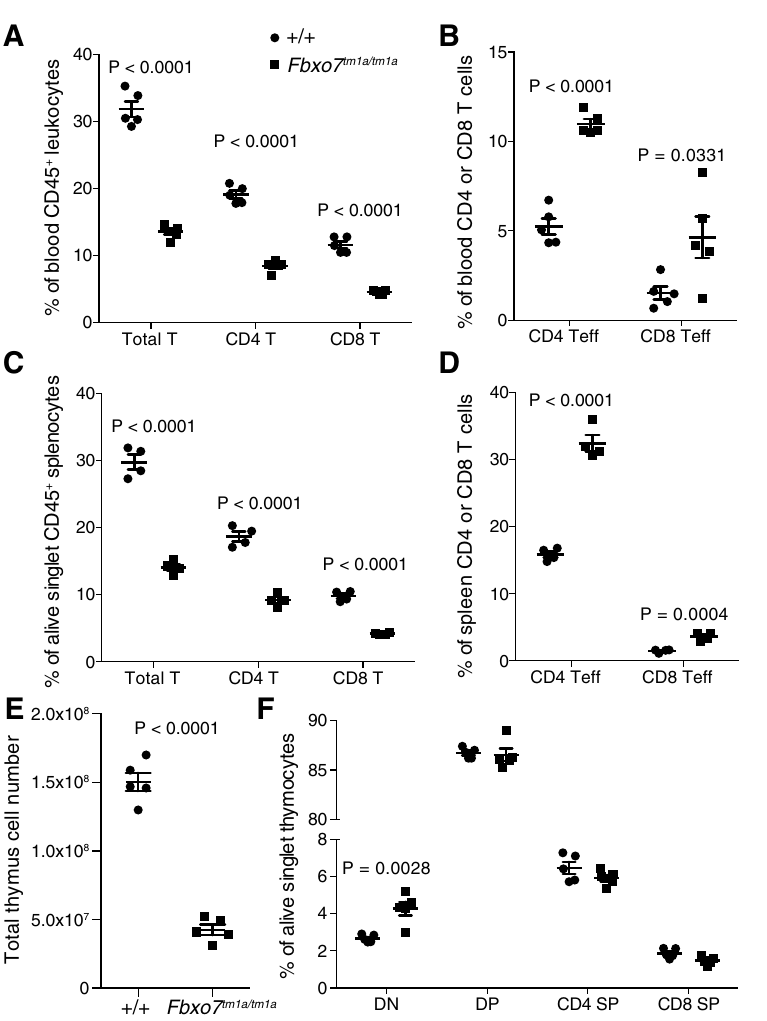
Fig 3. Fbxo7 tm1a mice have reduced circulating T cells with an altered phenotype and impaired T cell development. (A) Circulating T cell percentage in peripheral blood, (B) blood T cell effector percentage. (C) T cell percentage in the spleen and (D) splenic T cell effector percentage. (E) total thymus cell number and (F) T cell developmental stages in the thymus, DN = CD4/CD8 double negative, DP = CD4/CD8 double positive, CD4 SP = CD4 single positive and CD8 SP = CD8 single positive. All mice were female and 8 weeks old. P values from an unpaired two-tailed students t test with Holm-Sidak multiple testing correction except panel E which is from unpaired two- tailed students t tests with Welch’s correction. All data representative of three independent experiments, each symbol represents an individual mouse with the line at the mean and error bars represent standard error of the mean.